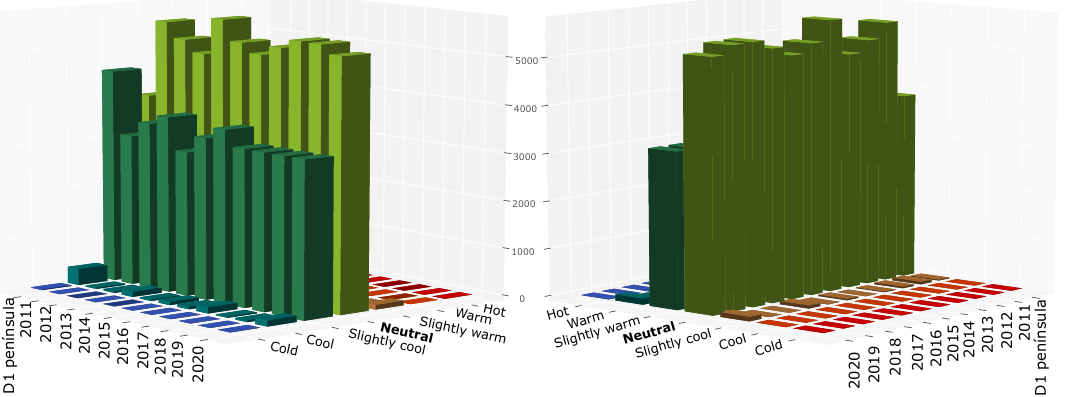
Figure 5. Comfort results taking into account the CTE-2013 standard and the Pamplona actual meteorological years (AMY).